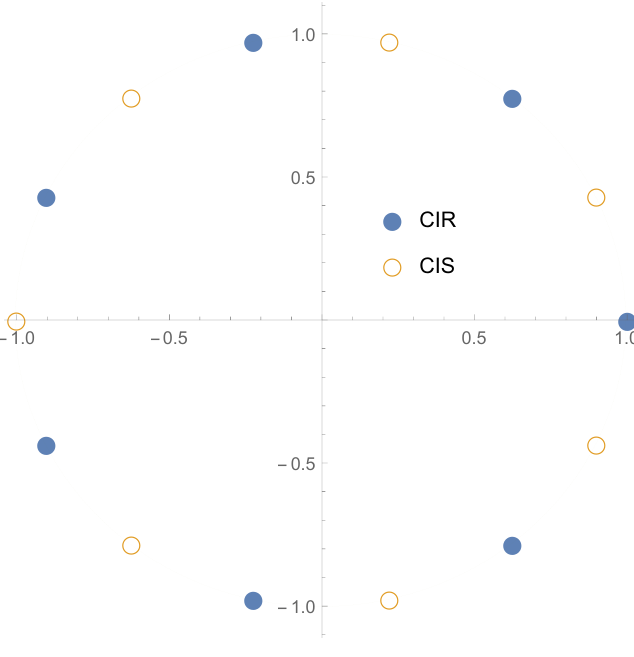
Figure 3. Nodes of the CIR and CIS NIZT methods for N = 7 in the complex plane